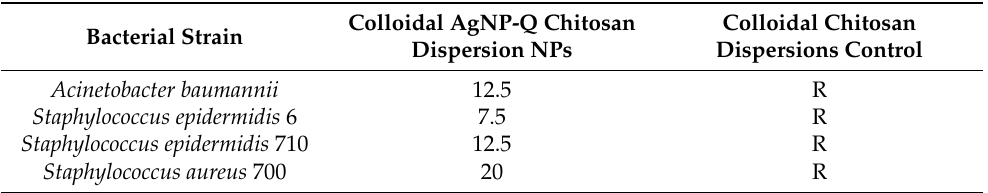
Table 1. Antibacterial activity of colloidal chitosan dispersions against multidrug-resistant bacteria expressed as MIC ( µ g/mL).